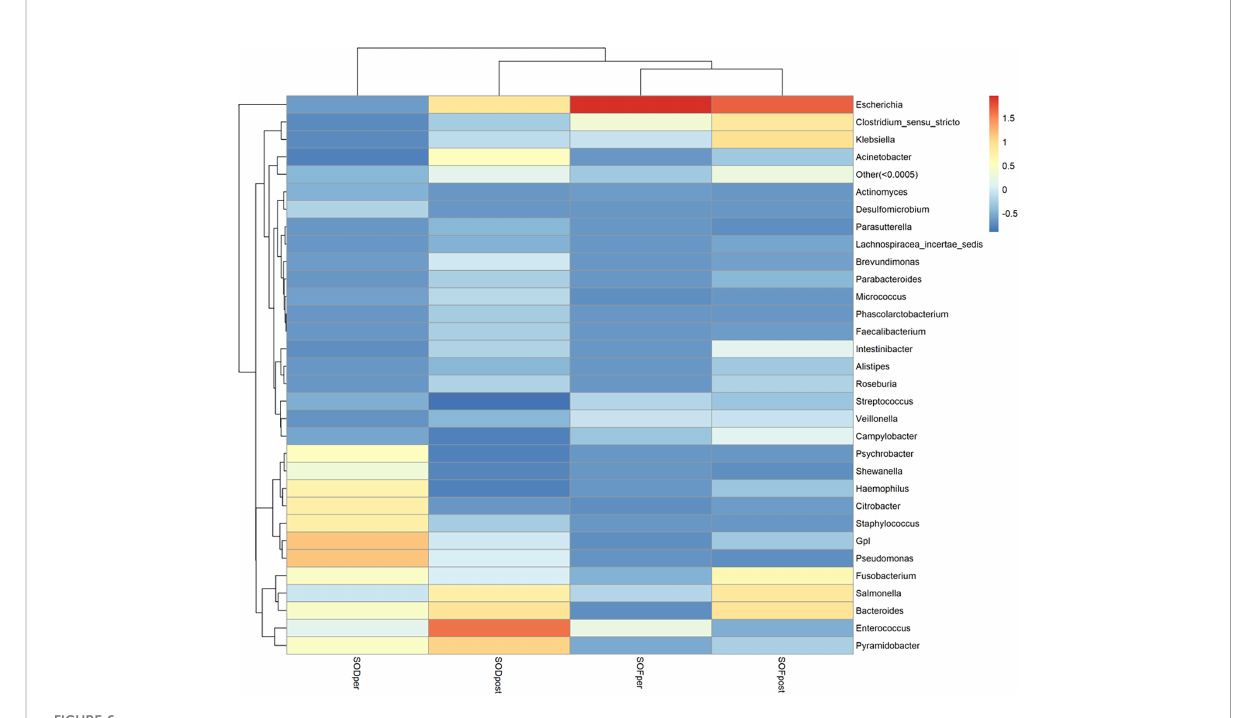
FIGURE 6 Cluster heat map of species abundance at each genus